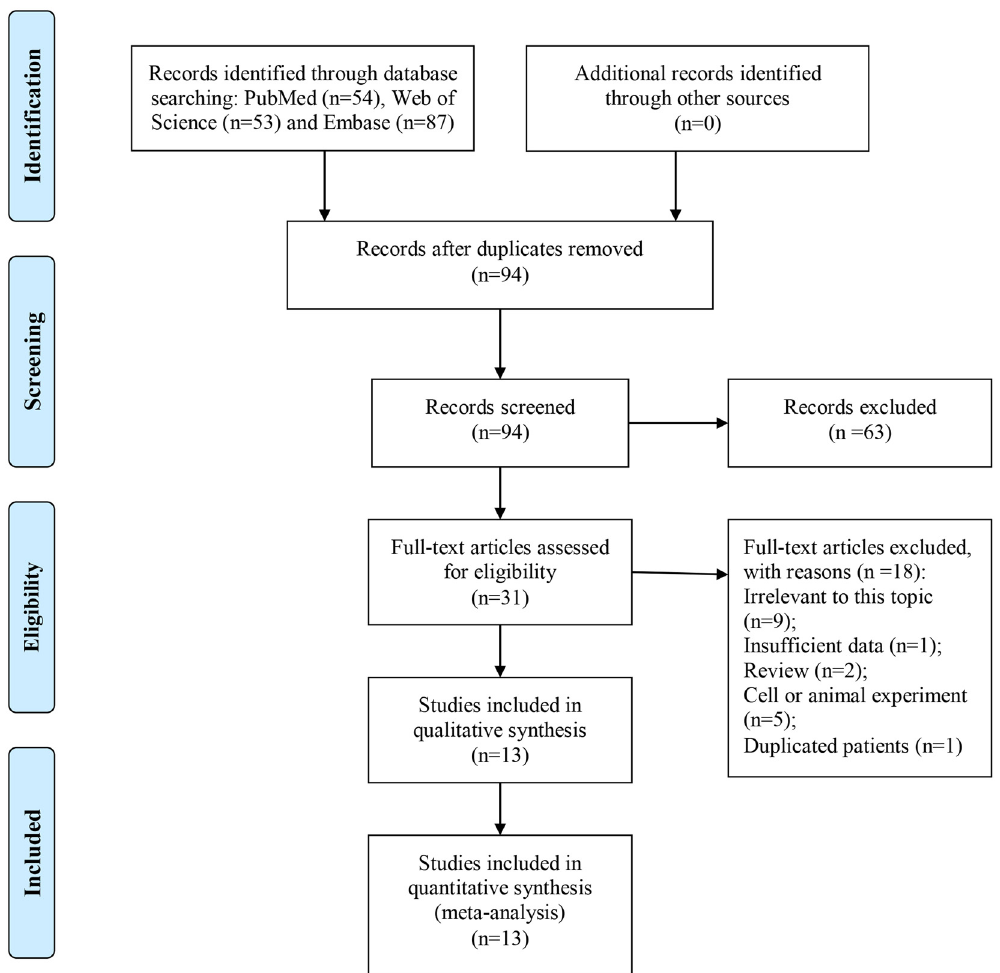
Figure 1: Flowchart of literature search and